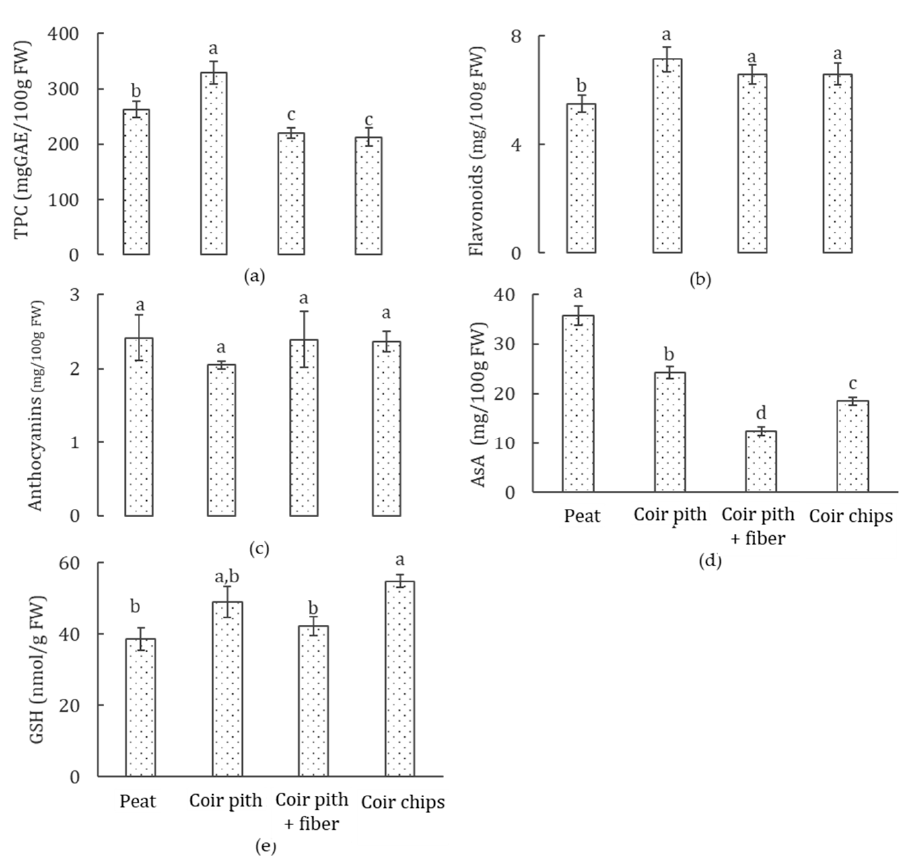
Figure 5. Contents of total phenolic compounds (TPCs) ( a ), flavonoids ( b ), anthocyanins ( c ), ascorbic acid (AsA) ( d ), and glutathione (GSH) ( e ) in the leaf blade. Means with different letters are significantly different at p < 0.05; FW—fresh weight. Each bar represents the mean of five replicates, and the error bars represent ± 1SE.